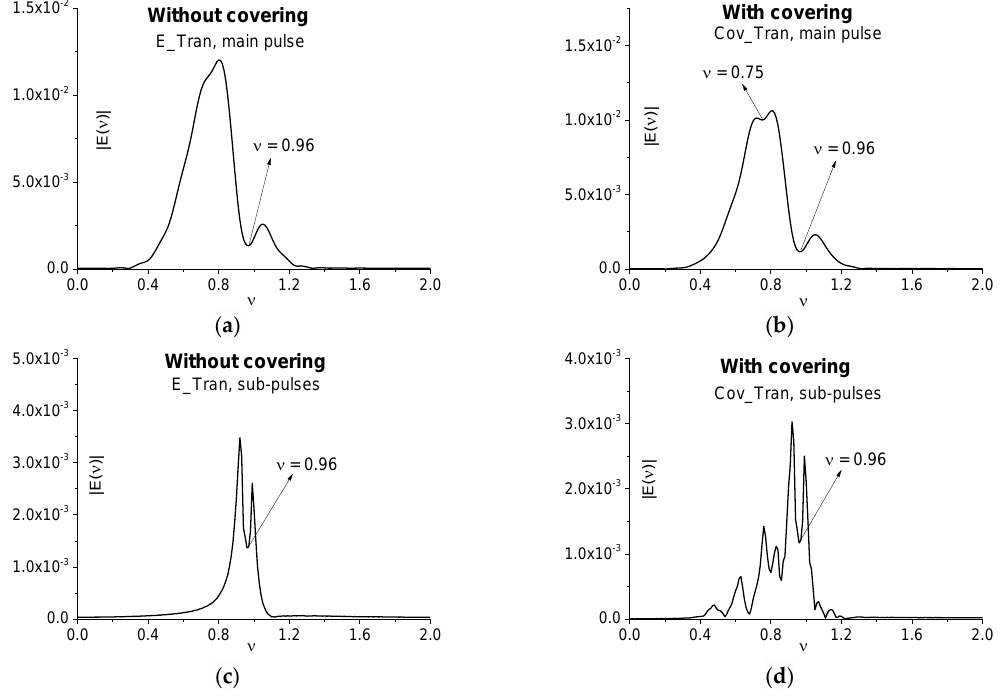
Figure 7. Fourier spectra of the main pulse ( a ), ( b ) and sub-pulse ( c ), ( d ) of the signal transmitted through the medium without (E_Tran) ( a ), ( c ) and with (Cov_Tran) covering ( b ), ( d ). The corresponding time intervals are equal to t = [0, 34] ( a ), [0, 36] ( b ), [34, 100] ( c ), [36, 100] ( d ). Spectral resolution is equal to Δν = 0.01.